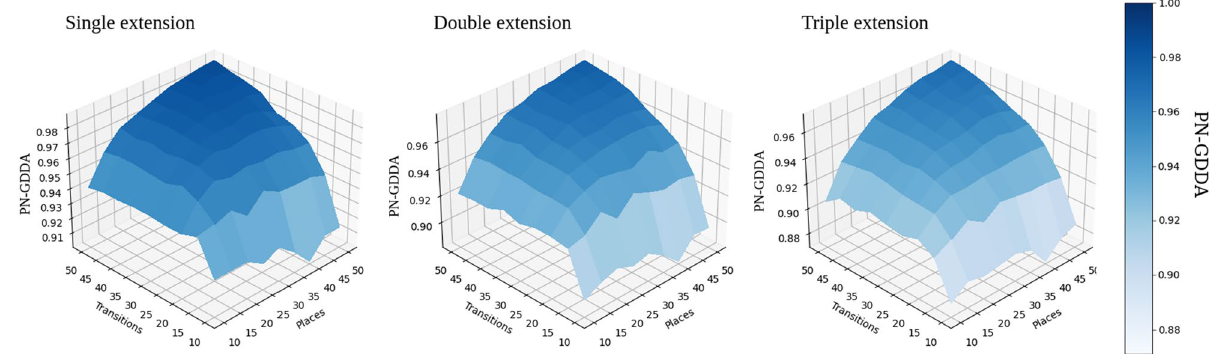
Figure 14. Changes of PN-GDDA value due to singular, multiple and triple extensions by the same A structure (Data used for diagrams can be found in Tables S4, S1, S11 from Supplementary Material) 20